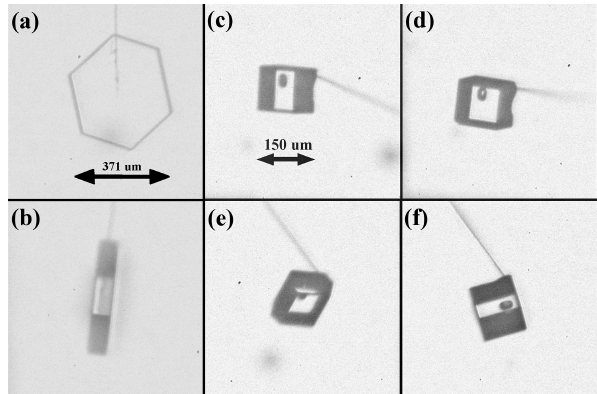
Figure 3. Crystals grown on capillary C f and C b . Both crystals nu- cleated and grew at the same time at − 17 ◦ C and about 1% super- saturation. (a) C f front view. (b) C f side view. ( c–f) are four views of C b where the difference in capillary direction is due to capillary rotation and the curvature of the